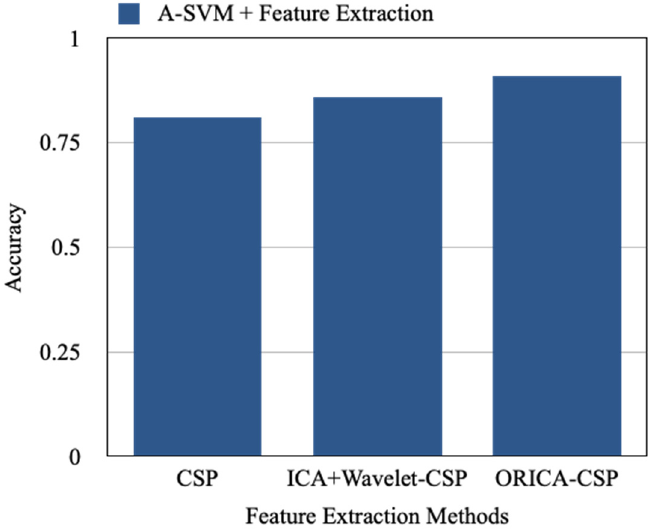
Figure 12. Average accuracy of A-SVM with various feature extraction methods.